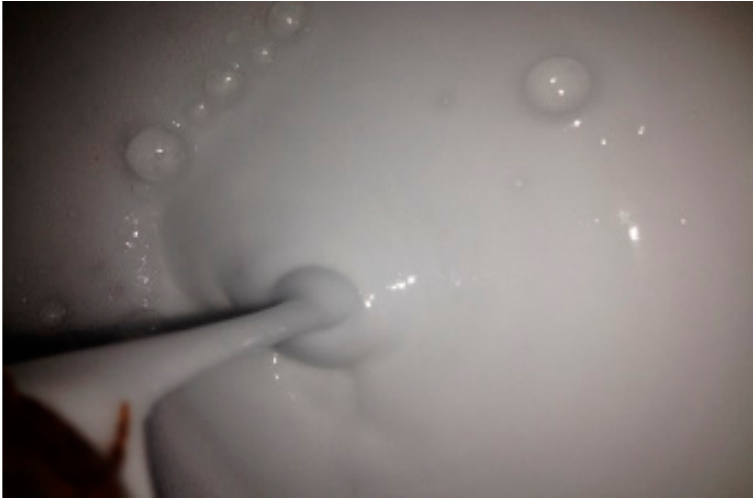
Figure 21. CO 2 foam gel fracturing fluid.